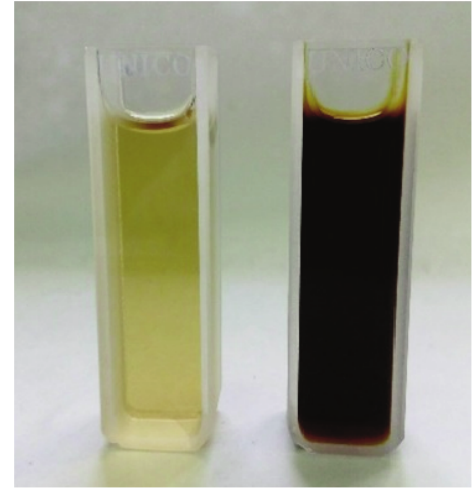
Fig. 1 ­ The mixture of C. myx a leaf extract and AgNO green­synthetized AgNPs colloidal solution (Right).